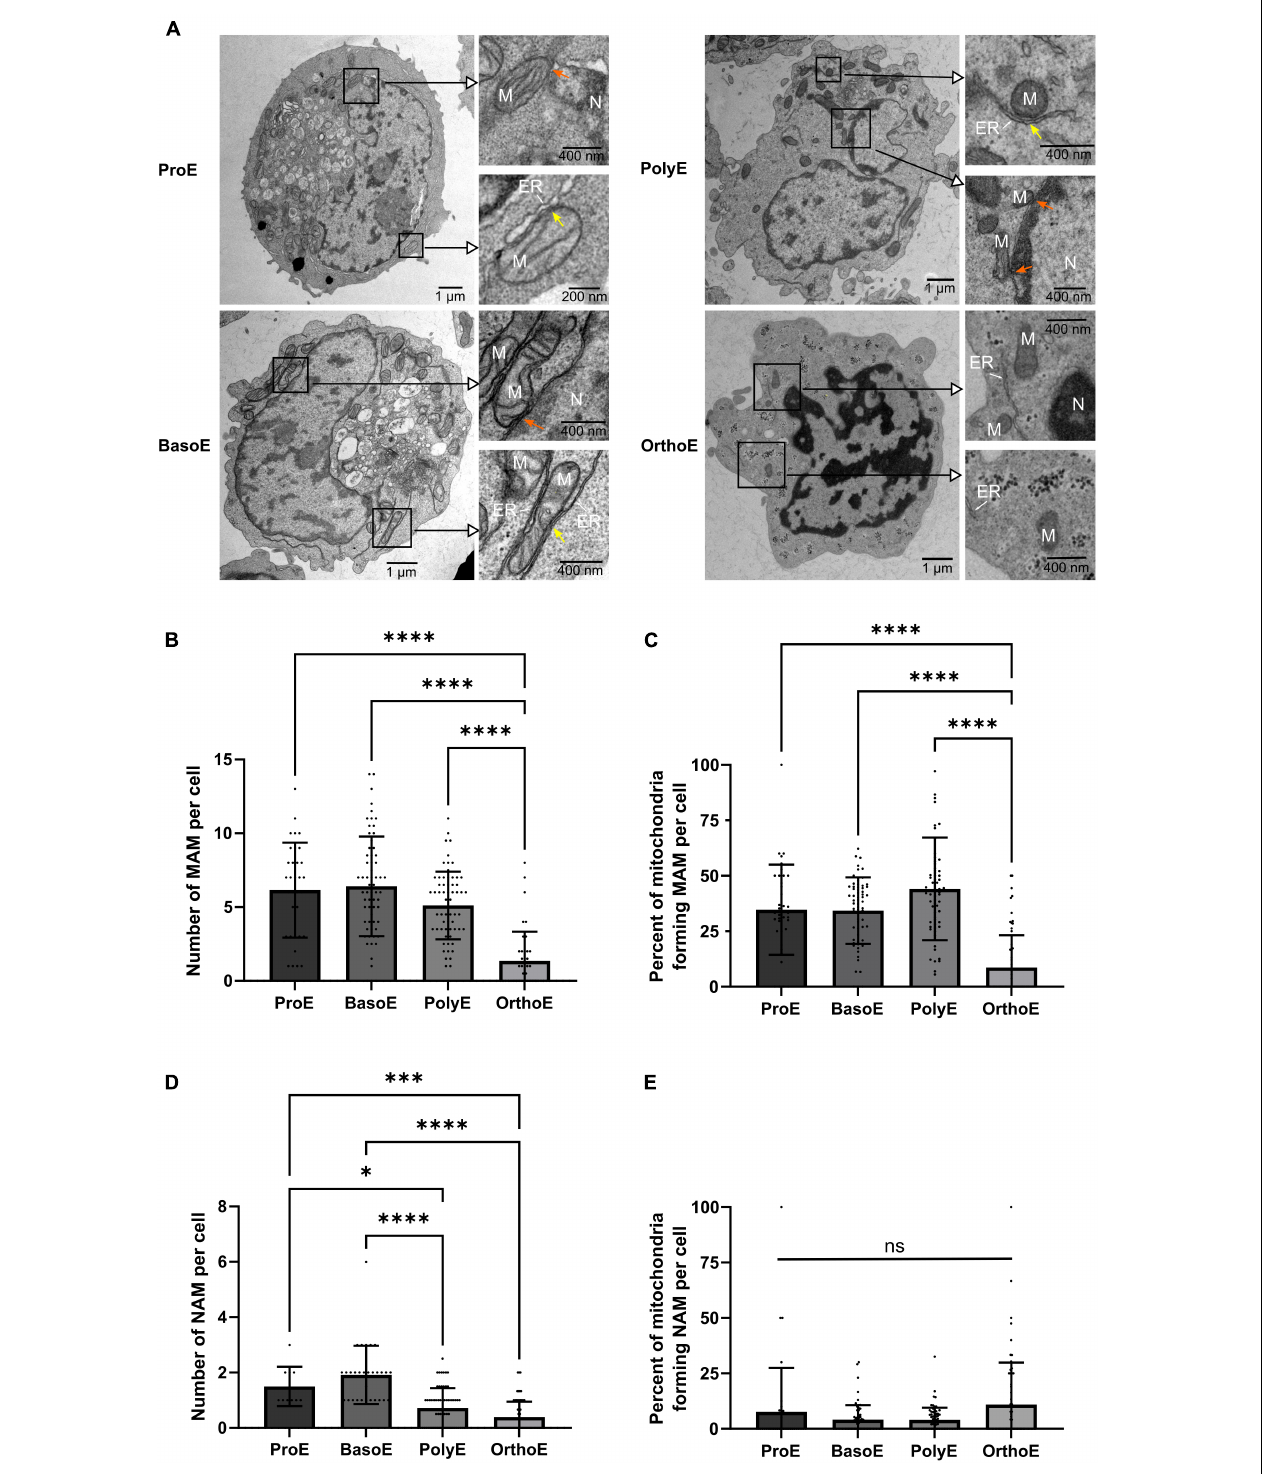
FIGURE 4 | Quantification of mitochondria-organelle contact sites. (A) Representative images of erythroblasts at various stages with insets on mitochondria. Orange arrow: mitochondria-ER contact site, yellow arrow: mitochondria-nucleus contact site. M, mitochondria; N, nucleus; ER, endoplasmic reticulum. (B) Quantification of mitochondria-endoplasmic reticulum (MAM) per cell at each stage. (C) Percentage of mitochondria forming MAM contact site per cell. (D) Quantification of nucleus-mitochondria (NAM) per cell at each stage. (E) Percentage of mitochondria forming NAM contact site per cell. Kruskal–Wallis analysis on at least 20 images for the three replicates. * p < 0.05; **** p <